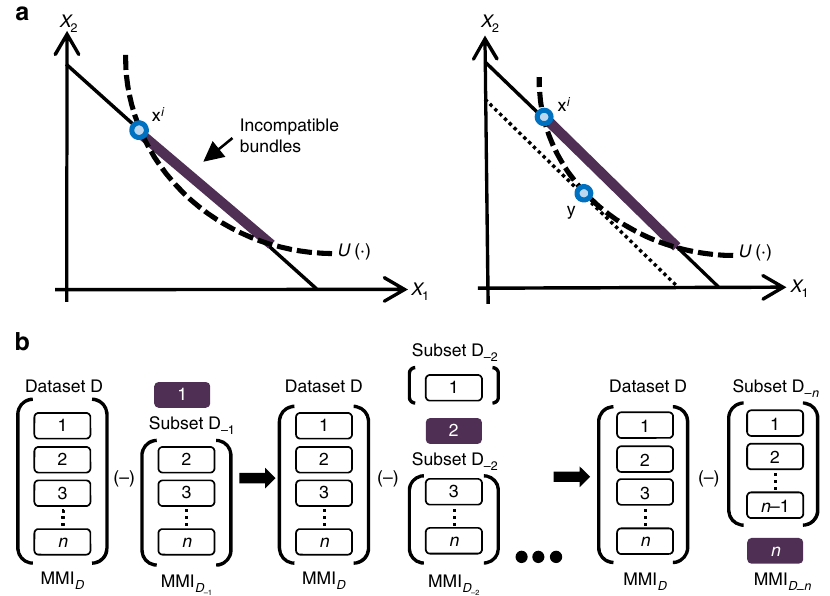
Fig. 1 A trial-speci fi c inconsistency index. a Computation of the MMI. Let u ( ∙ ) be some utility function and let x i be the bundle chosen by the subject in the trial i . A utility function induces a complete ranking on the bundles, i.e., if u x ð Þ > u y ð Þ , then the bundle x is ranked above bundle y . Also, by the revealed preference principle 72 , when the subject chooses bundle x i , she reveals that she ranks this bundle over all other feasible bundles. These two rankings may be incompatible as shown in the fi gure: u ( ∙ ) ranks all the bundles in the purple bold interval as better than bundle x i , while the subject ranked x i as her most desired bundle in the given budget set. The extent of this incompatibility is measured by computing the maximal expenditure for which the two rankings agree (the minimal parallel inward adjustment of the budget line). Given the utility function u ( ∙ ), we use average sum of squares to aggregate these adjustments over all observations. For a set of utility functions U , we choose the utility function u ( ∙ ) for which the aggregate adjustment is minimal. We refer to the aggregate adjustment of this u ( ∙ ) as the MMI for the entire dataset D given the set of utility functions U . b Leave-One-Out procedure. Denote the dataset by D . Denote the dataset that is generated by removing observation i from dataset D by D between the aggregate index MMI D calculated for the entire dataset D and the aggregate index MMI D index for observation i is MMI D (cid:2) MMI